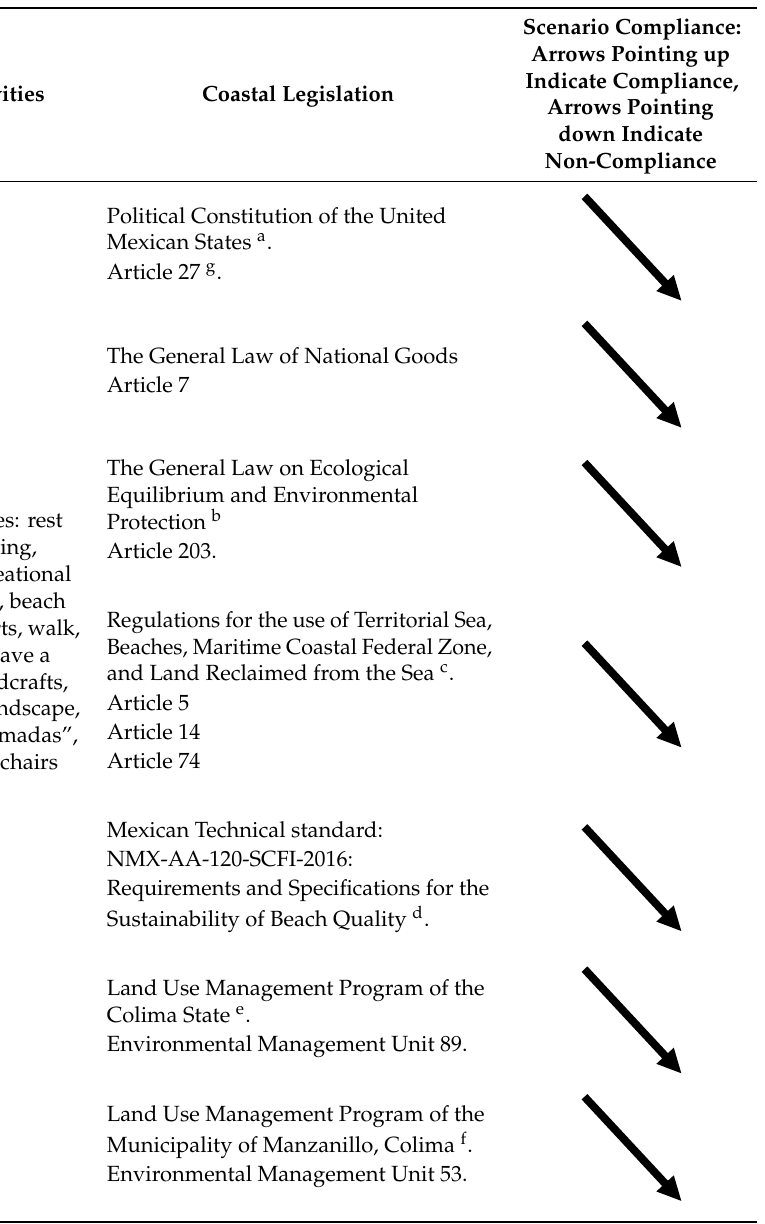
Table A3. Analysis of regulatory instruments (coastal legislation) applied to the La Boquita Coastal System